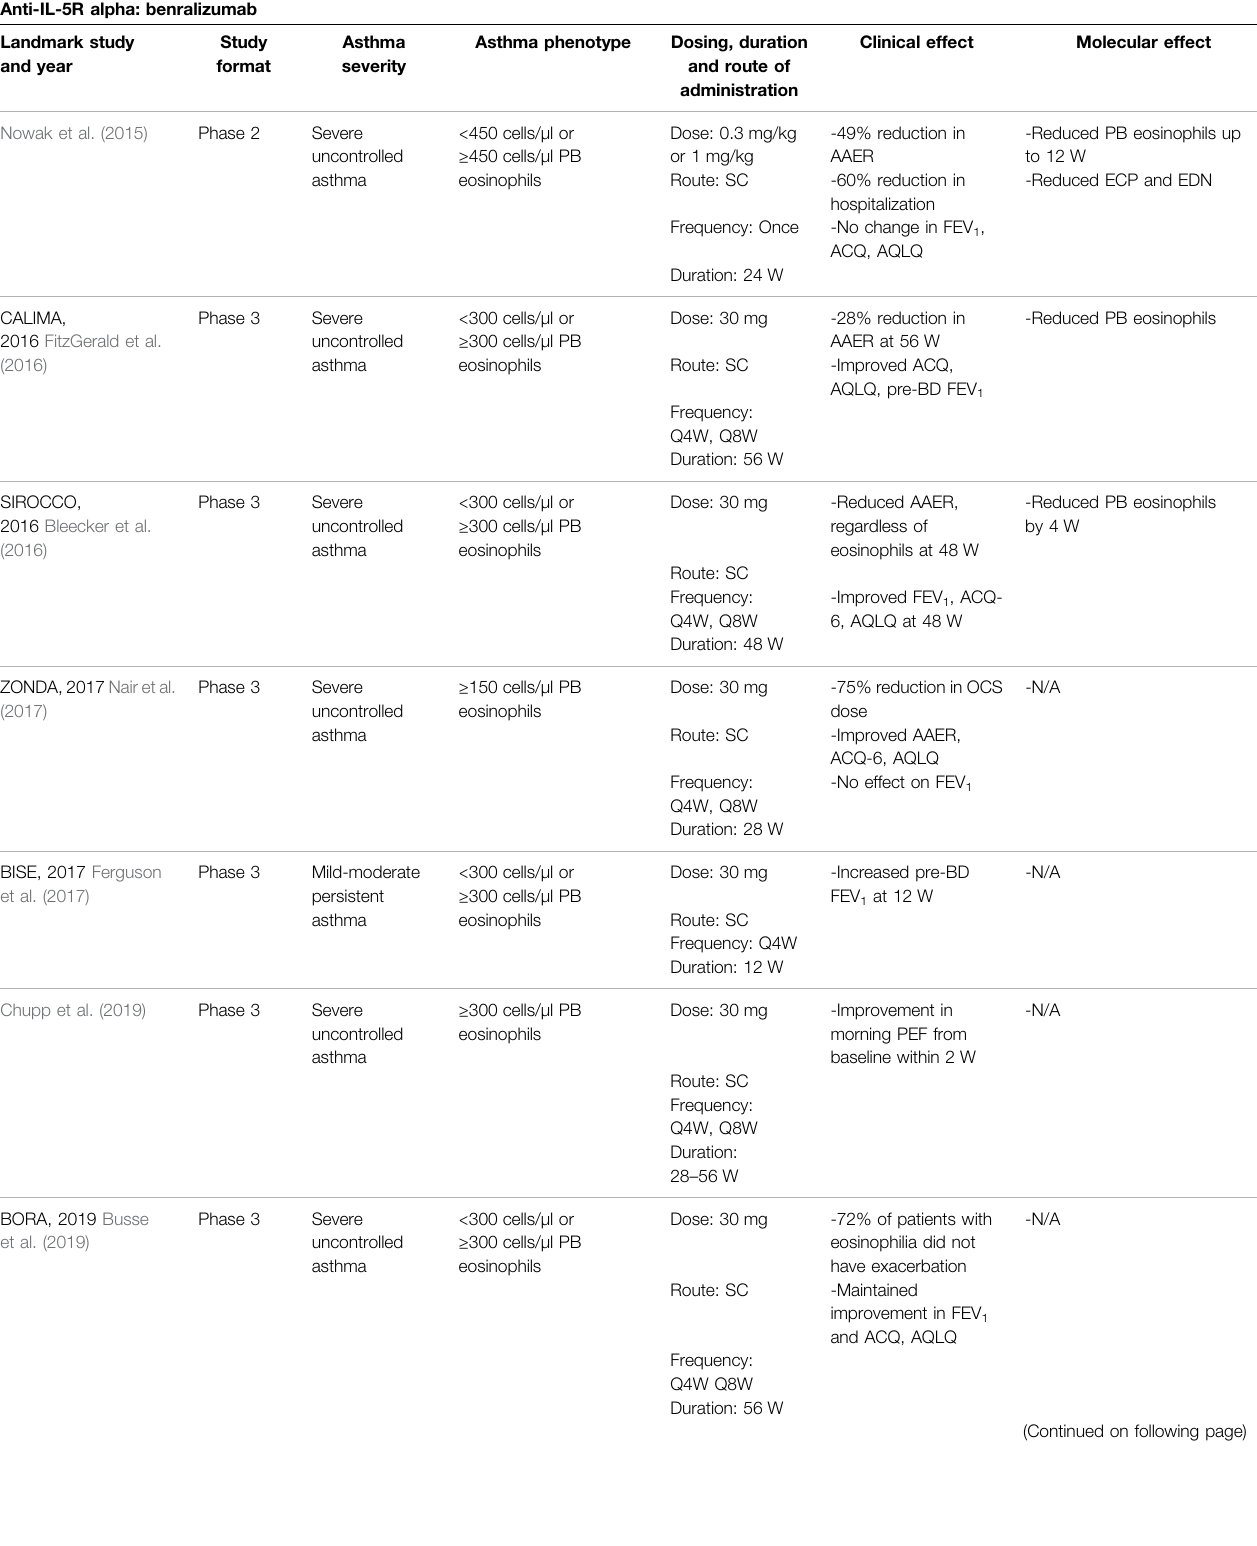
TABLE 4 | Summary of randomized clinical trials assessing benralizumab in severe